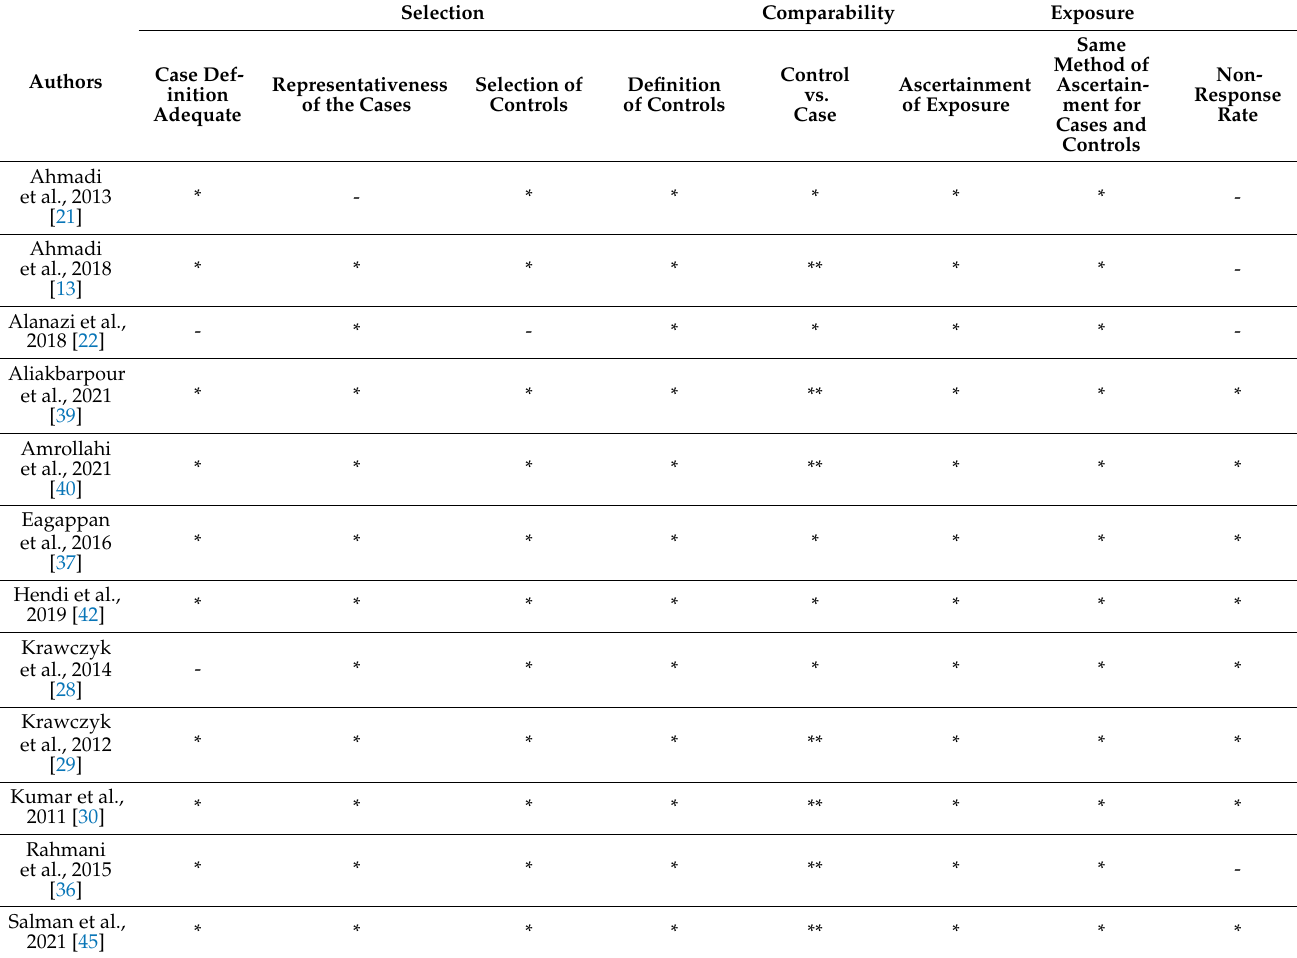
Table 2. Newcastle-Ottawa tool for case-control studies.